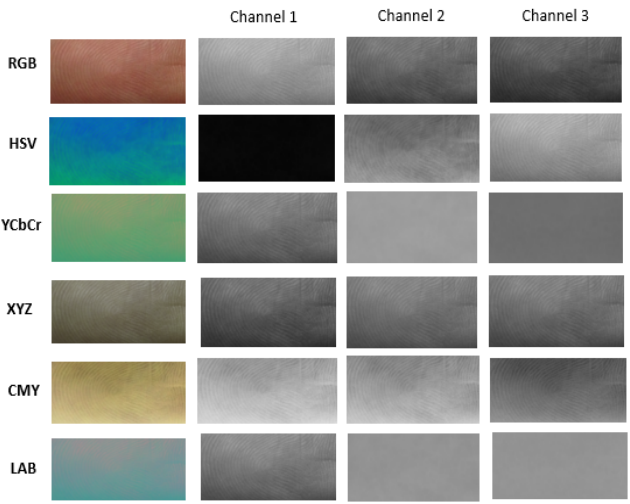
Figure 2. Examples of finger photo center core patches converted into different color